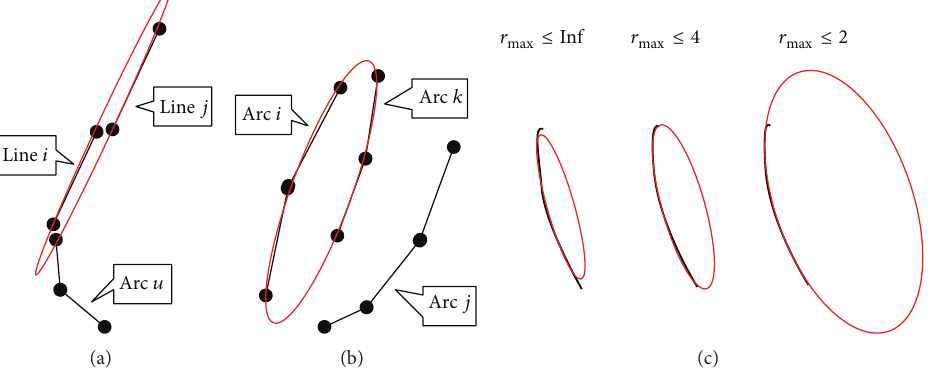
Figure 8: Problems of regular ellipse fitting methods and the fitting results with different 𝑟 max . (a) Line 𝑖 should be merged with Arc 𝑢 but is incorrectly merged with Line 𝑗 into a flat ellipse. (b) Arc 𝑖 should be merged with Arc 𝑗 but is incorrectly merged with Arc 𝑘 . (c) Ellipse fitting results with 𝑟 max = +∞ , 𝑟 max = 4 , and 𝑟 max = 2 by the proposed fitting